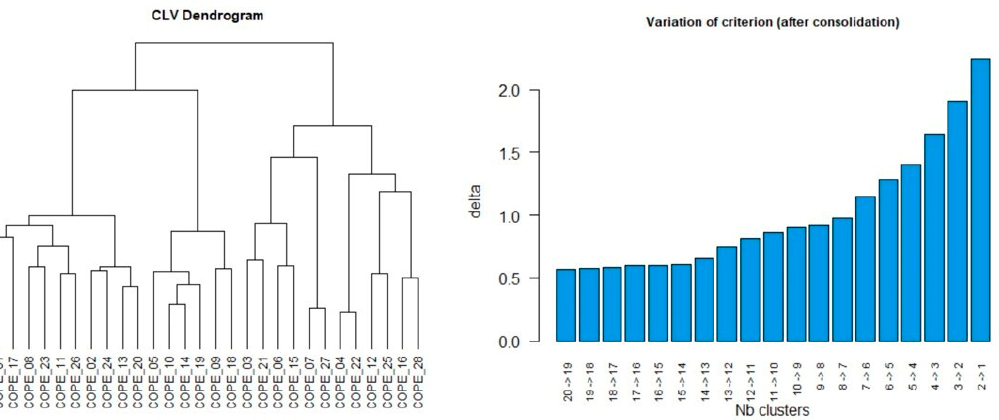
Figure 1. Graphs obtained by directional clustering of psychological variables. On the left, the dendrogram of the hierarchical clustering step; on the right, the variation of the clustering criterion after consolidation of the partitions using the partitioning algorithm.